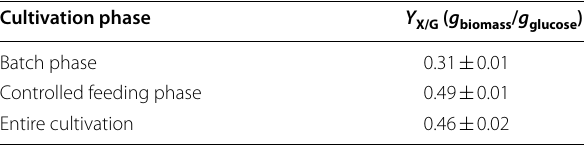
Table 1 Yield coefficients during the fed-batch